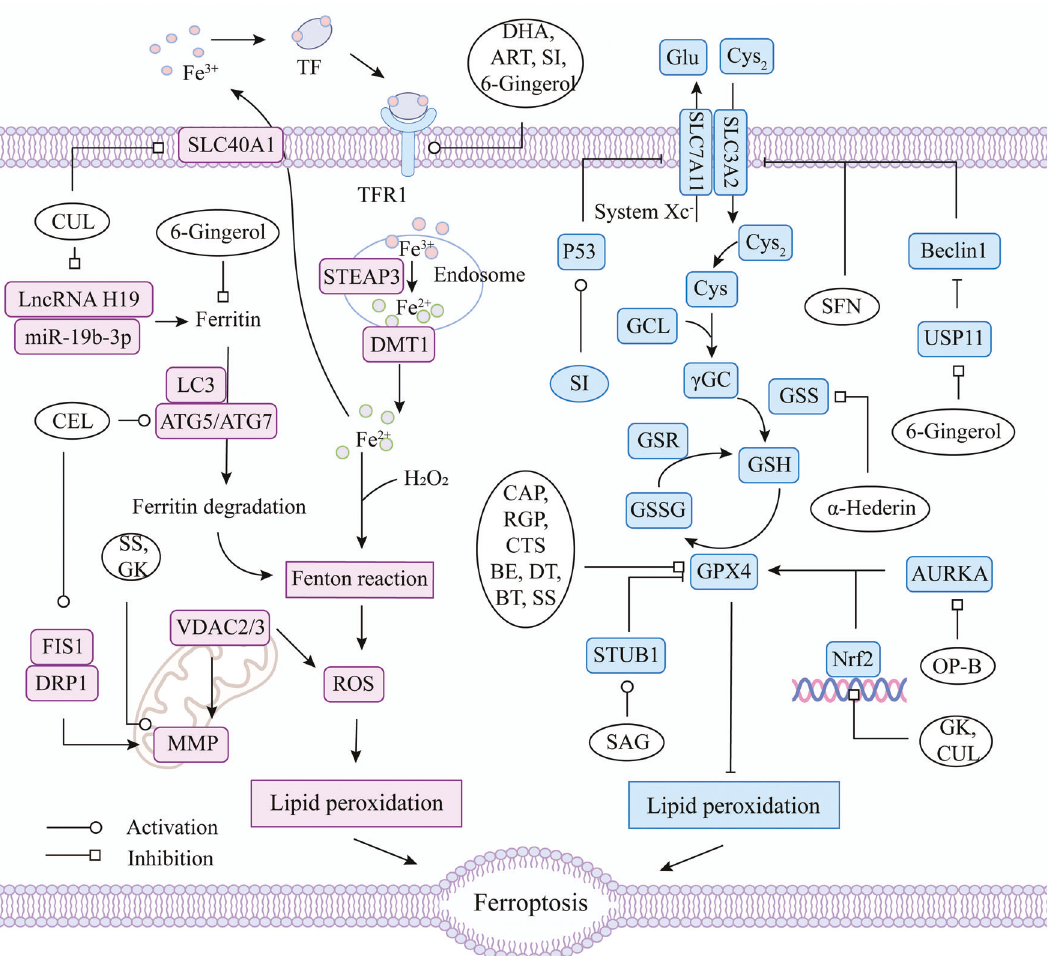
Fig. 6 Regulatory mechanisms of natural drugs targeting ferroptosis in lung cancer. ART Artesunate, DHA Dihydroartemisinin, CUL Curcumenol, CEL Celastrol, BE Betulin, SAG Sanguinarine, SI Sinapine, SS Solasonine, CAP Capsaicin, ERI Erianin, DT Dihydroisotanshinone I, CTS Cryptotanshinone, OP-B Ophiopogonin-B, GK Ginkgetin, BT Bufotalin, SFN Sulforaphane, RGP Red ginseng polysaccharide, SLC40A1 solute carrier family 40 member 1, HO-1 Heme oxygenase 1, LC3 microtubule-associated protein 1 light chain, ATG5 autophagy- related protein 5, ATG7 autophagy-related protein 7, PRIM2 DNA primase polypeptide 2, FIS1 mitochondrial adaptor fi ssion 1, DRP1 dynamin related protein 1, FTH1 ferritin heavy chain 1, AURKA Aurora kinase A, USP11 ubiquitin-speci fi c processing protease 11, MMP mitochondrial membrane potential, miRNA MicroRNA, lncRNA Long non-coding RNA, DMT1 solute carrier family 11 member 2, Nrf2 nuclear factor erythroid 2-related factor 2, p53 tumor suppressor protein, GPX4 glutathione peroxidase 4, System Xc − cystine/glutamate antiporter system, Cys 2 cystine, Glu glutamate, Cys cysteine, Gly glycine, GCL glutamate-cysteine ligase, SLC3A2 solute carrier family 3, member 2, SLC7A11 solute carrier family 7 (L-type amino acid transporter), member 11, GSS glutathione synthetase, GSH glutathione, GSSG oxidized glutathione, GSR glutathione reductase, ROS reactive oxygen